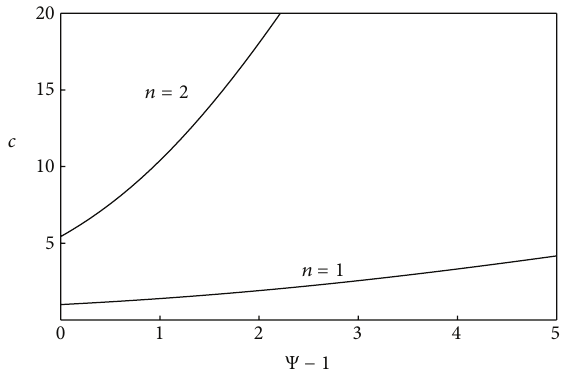
Figure 3: Velocity, 𝑐 , of a rarefactive solitary wave for 𝑛 = 1 and 2 plotted against amplitude Ψ − 1 . Both velocities are scaled by the characteristic velocity, 𝛿 𝑐 /𝑡 0 , for 𝑛 = 1